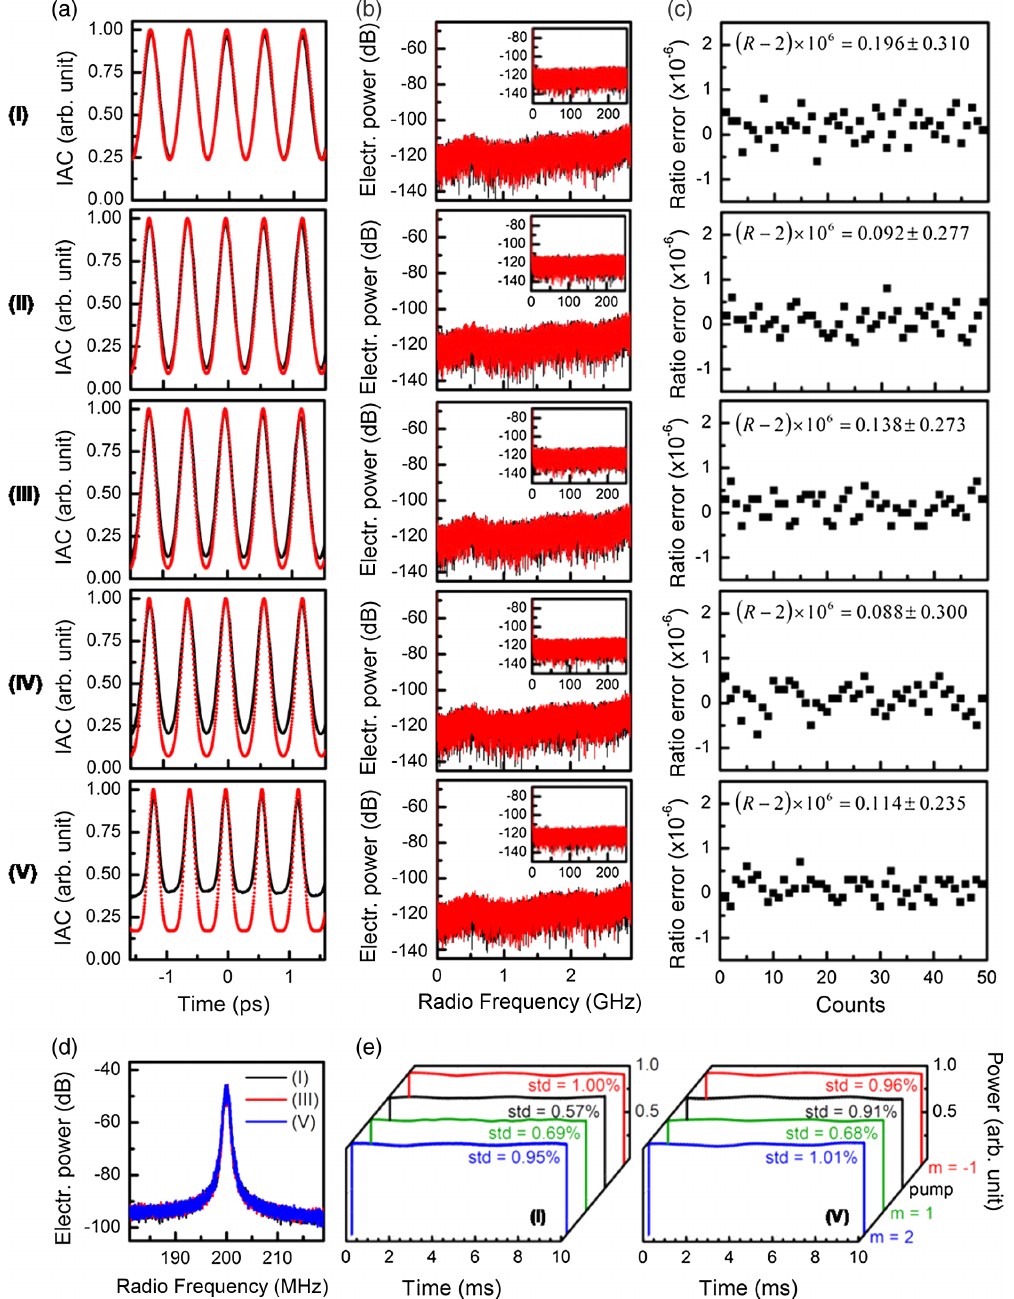
FIG. 3. (a) IAC traces of the Turing rolls at different stages. The red dashed lines are the ideal traces calculated from the spectra, while the black curves are the measured traces. As the sidebands grow, the deviations between the measured and calculated IAC traces also increase. (b) To examine the emergence of incommensurate subcombs, RF amplitude noise spectra of the Turing rolls (black curve) along with the detector background (red curve) are measured up to 3 GHz, 6 times the cavity linewidth. No apparent amplitude noise is observed, verifying the existence of the commensurate subcombs. Inset: Zoom-in RF amplitude noise spectra up to 250 MHz, at the instrumentation detection noise floor. (c) To probe the equidistance of the Turing rolls, the beat notes between the three Turing-roll sidebands (pump, m ¼ 1 , and m ¼ 2 ) and the adjacent fiber-laser frequency-comb lines are measured, and the ratio errors are presented. The small deviation from the ideal ratio R of 2 [ R defined in the main text as ð δ 2 − δ 0 Þ = ð δ 1 − δ 0 Þ ] verifies the Turing pattern ’ s excellent uniformity. The average nonuniformity is measured at 125 mHz, or 7 . 3 × 10 − 14 when referenced to the Turing pattern repetition rate at 1.72 THz. (d) The linewidth of the first sideband is measured at 500 kHz, limited by the coherence of the pump laser, by the self- heterodyne technique at different stages. No linewidth broadening is observed, independently confirming that the coherence of the Turing roll is maintained at all evolving stages. (e) Power fluctuation of individual sidebands at the stages I (left) and V (right) with a sampling rate of 250 MHz, ruling out the possibility of breathing solutions.